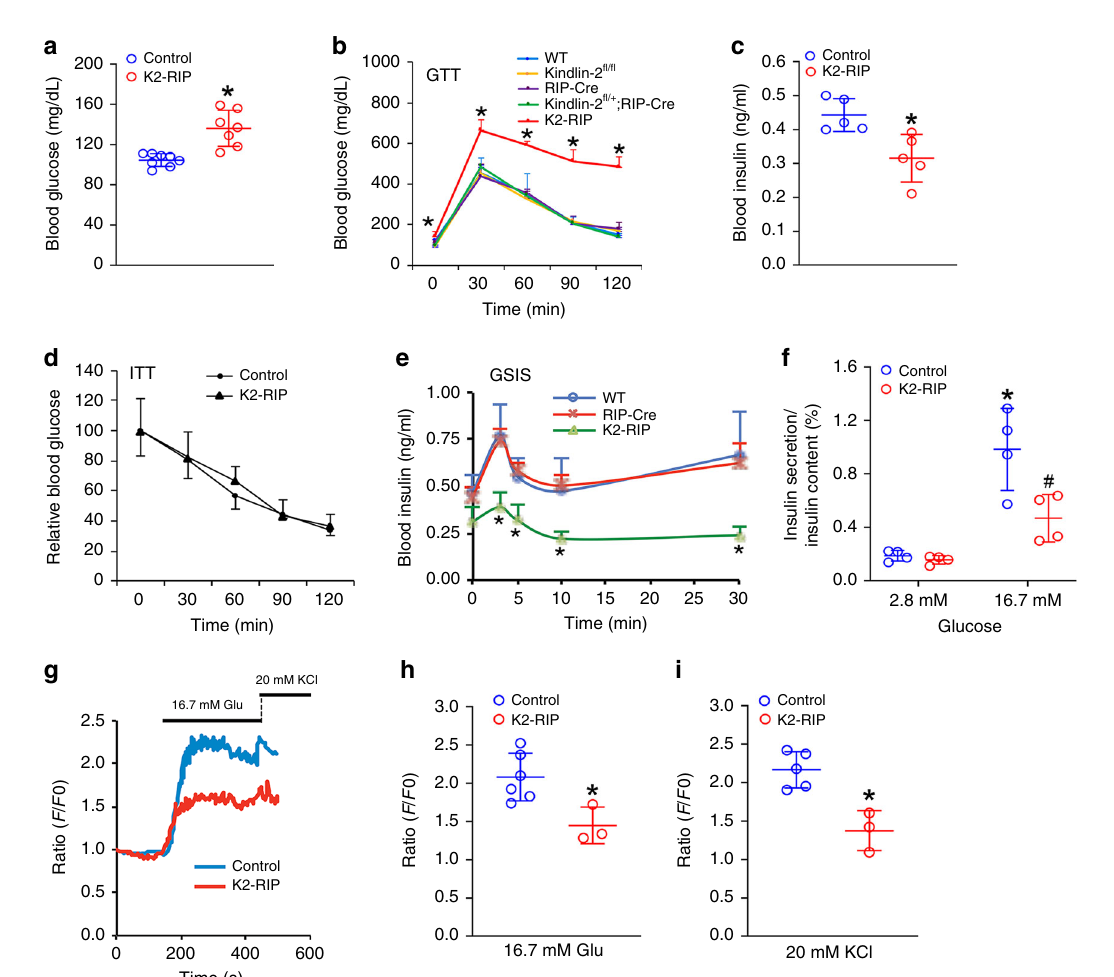
Fig. 2 Kindlin-2 loss causes severe diabetes-like phenotypes without affecting insulin sensitivity. a Fasting blood glucose level. Two-month-old male control ( RIP-Cre ) and K2-RIP mice were fasted overnight. * P < 0.05, versus control, N = 8 for control, N = 7 K2-RIP , b GTT. Mice treated as in a were given intraperitoneal injections of glucose (2 g/kg body weight). * P < 0.05, versus control, N = 5 for WT and K2-RIP , N = 6 for Kindlin-2 fl / fl , and N = 7 for RIP-Cre and Kindlin-2 fl / + ; RIP-Cre . c Blood insulin level. Mice were treated as in a . *P < 0.05, versus control, N = 5 mice per genotype. d ITT. Mice fasted (6 – 7 h) were intraperitoneally injected with a single dose of recombinant human insulin (1 U/kg body weight). * P < 0.05, versus control, N = 6 for control, N = 8 for K2-RIP . e In vivo GSIS. Mice treated as in a and intraperitoneally injected with glucose (2 g/kg body weight). Blood insulin levels were measured by ELISA at 0, 3, 5, 10, and 30 min after glucose injection. * P < 0.05, versus control, N = 5 for WT, N = 8 for RIP-Cre and K2-RIP . f In vitro GSIS. Islets isolated from 2- month-old male control K2-RIP mice were treated with 2.8 or 16.7 mM glucose. Amounts of insulin in supernatant were measured by ELISA assay. Proteins were extracted and total insulin content was measured. Supernatant insulin was normalized to total insulin content. * P < 0.05, versus 2.8 mM glucose, # P < 0.05, versus control. g Ca 2 + in fl ux. Representative results from control and K2-RIP islets are provided. N = 15 control islets, N = 20 K2-RIP islets. h Quanti fi cation of glucose (16.7mM) stimulation in control and mutant islets. N = 6 islets for control, N = 3 islets for K2-RIP , * P < 0.05, versus control. i Quanti fi cation of KCI (20 mM) stimulation in control and mutant islets. N = 5 islets for control, N = 3 islets for K2-RIP , * P < 0.05, versus control. Results are expressed as mean ± standard deviation (s.d.) and Student ’ s t test was used in this fi gure. Source data for a – f , h , i are provided as a Source Data fi